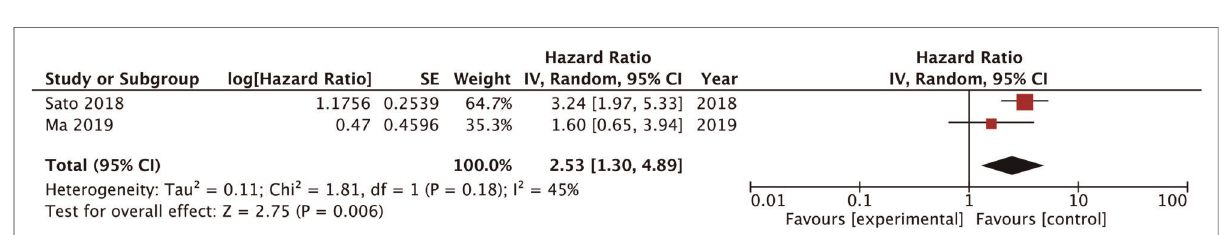
FIGURE 4 Meta-analysis of the association between SIS score of 2 vs. reference value of 0/1 for OS in gastric cancer patients. Blue boxes indicate the point estimates of individual studies and horizontal lines denote the con fi dence intervals. Black diamond indicates the total effect